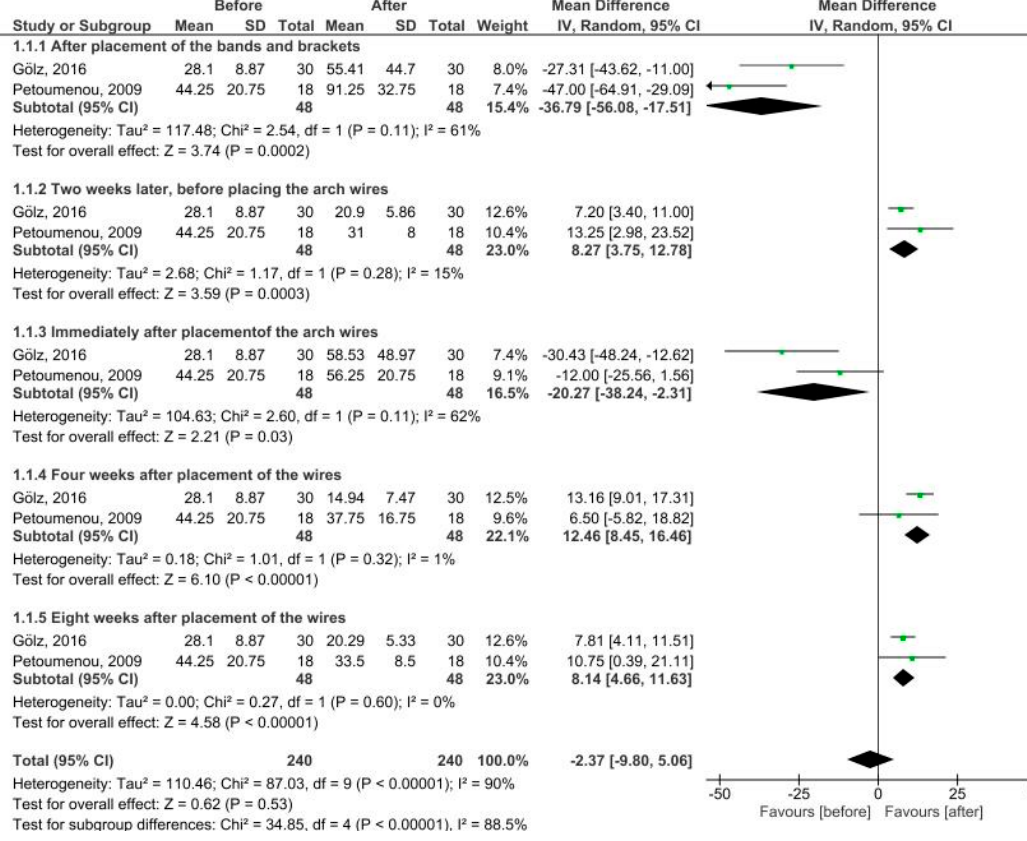
Figure 4. Forest plot of the random effect of salivary nickel levels in patients under fixed orthodontic treatment (before versus after treatment).